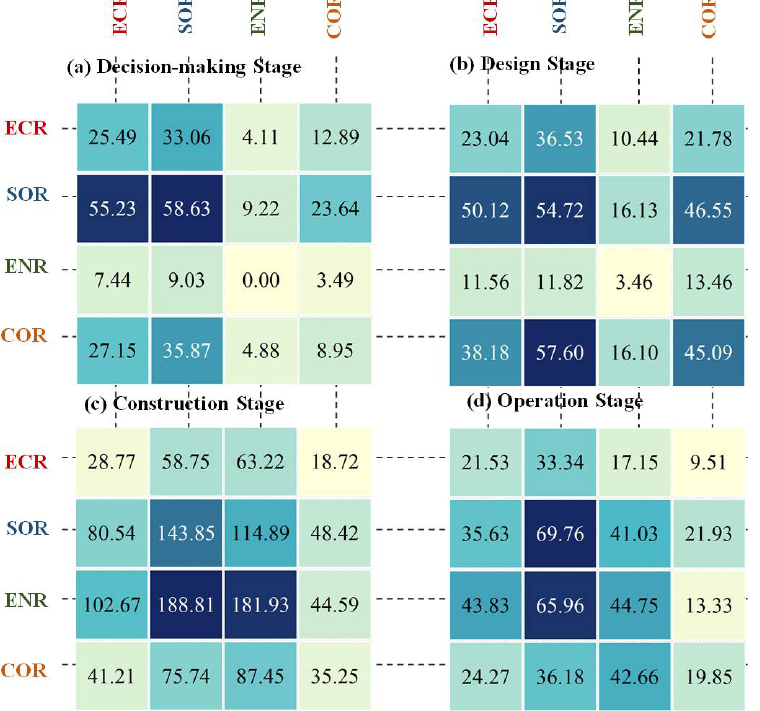
Figure 8. Global inter-group